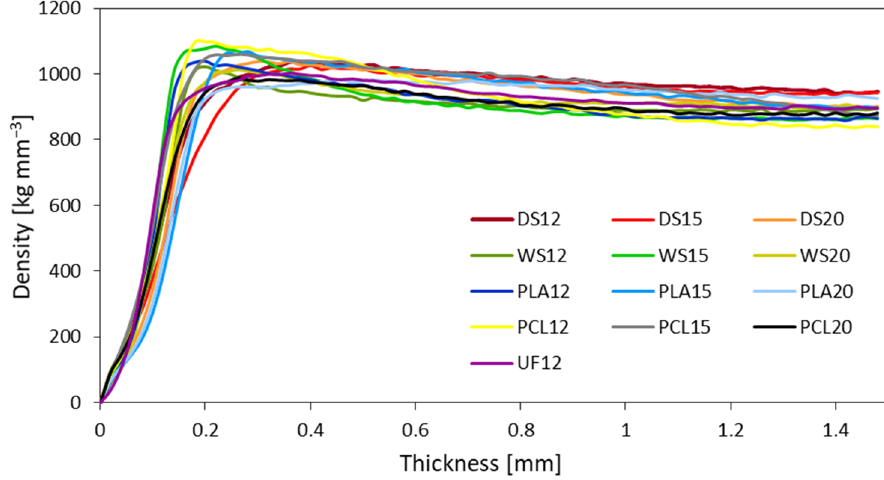
Figure 1. Density profiles of fiberboards.